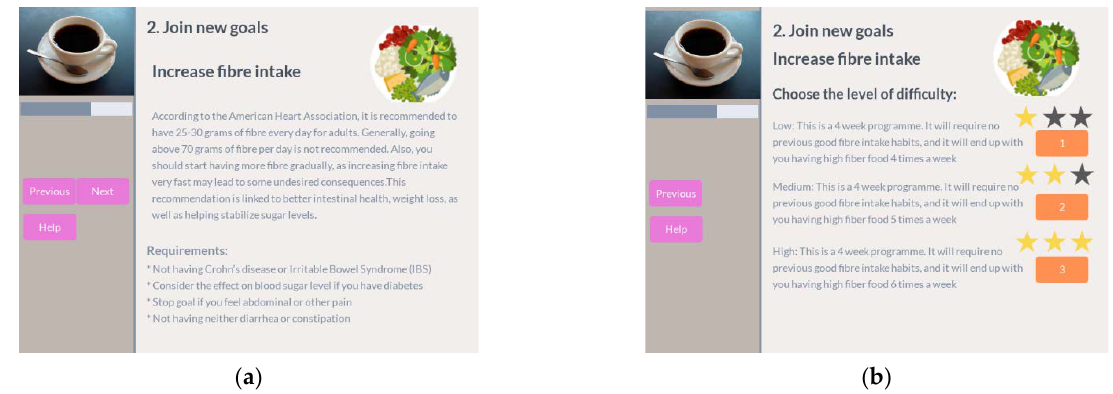
Figure 13. Join goal in coffee session. ( a ) Goal description and requirements; ( b ) set goal difficulty.